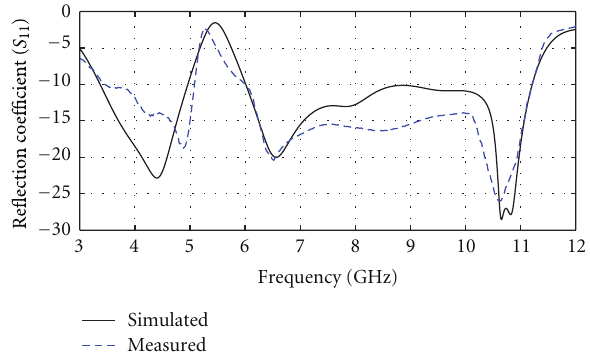
Figure 3: Ref. coe ffi cients S 11 (dB) versus frequency (GHz).